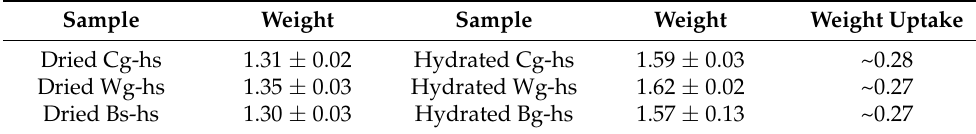
Figure 1. The photographs and impact sampling location of the three Caprinae horn sheaths: ( a ) Cashmere goat horn sheath; ( b ) White goat horn sheath; ( c ) Black sheep horn sheath. Table 1. Weight uptake of the samples after hydration (unit: g).